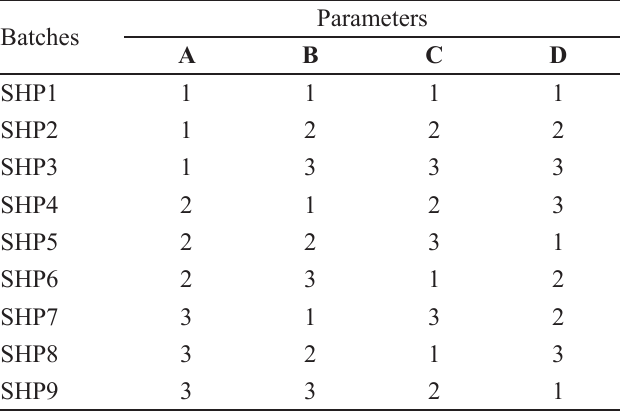
TABLE II - Taguchi L nanoparticles formulation